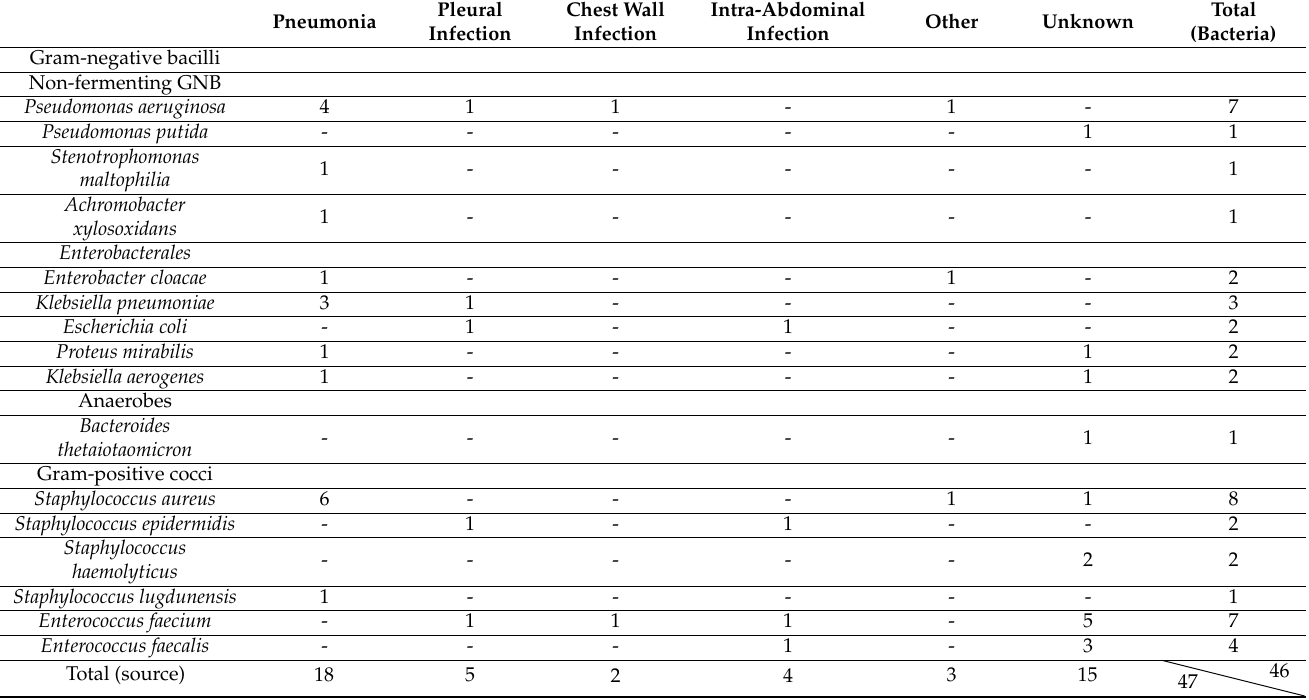
Table 2. Bacteria identified in positive blood cultures stratified by the source.